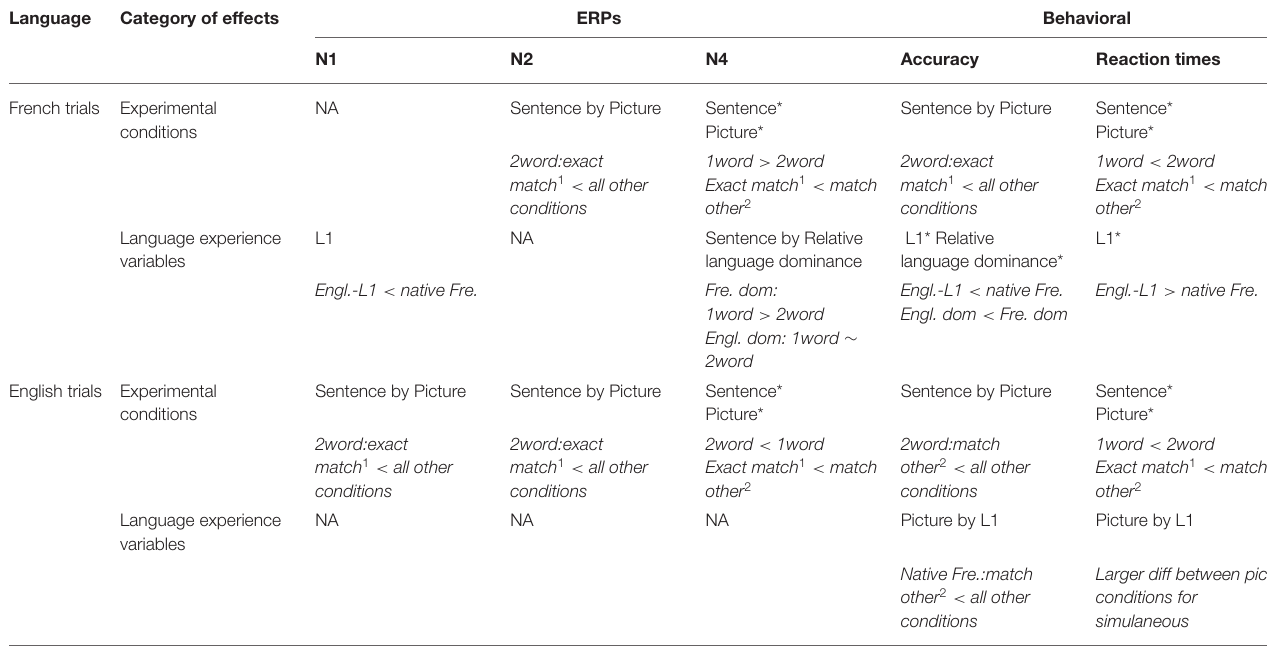
TABLE 4 | Summary of significant results.